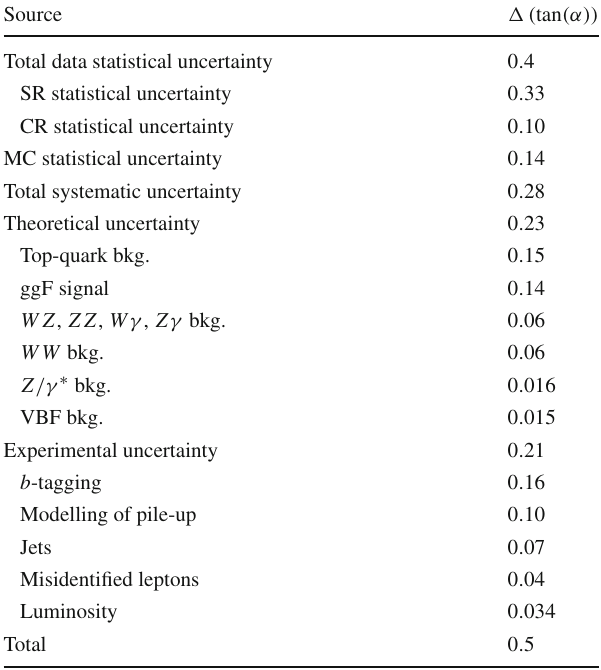
Table 7 Breakdown of the main contributions to the total uncertainty in tan (α) based on the fit that exploits both shape and rate information. Individual sources of systematic uncertainty are grouped into either the theoretical or the experimental uncertainty. The sum in quadrature of the individual components differs from the total uncertainty due to correlations between the components